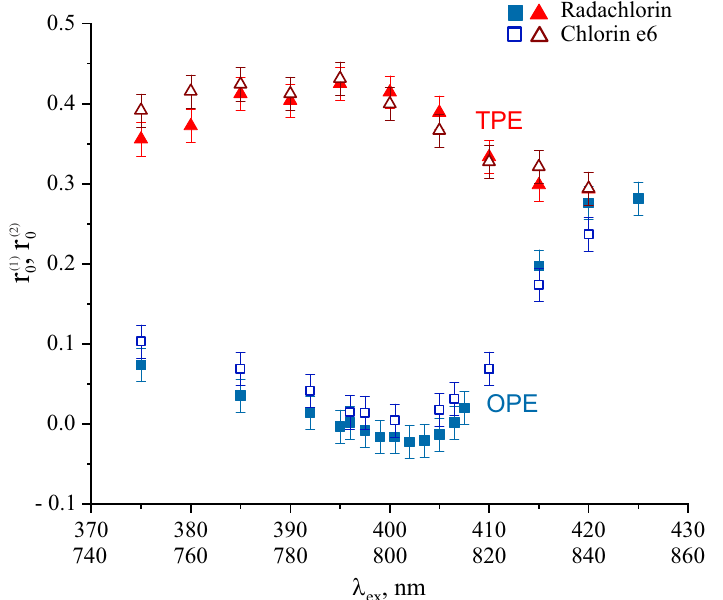
Figure 6. Anisotropy spectra of Radachlorin (filled symbols) and chlorin e6 (empty symbols) at OPE (squares) and TPE